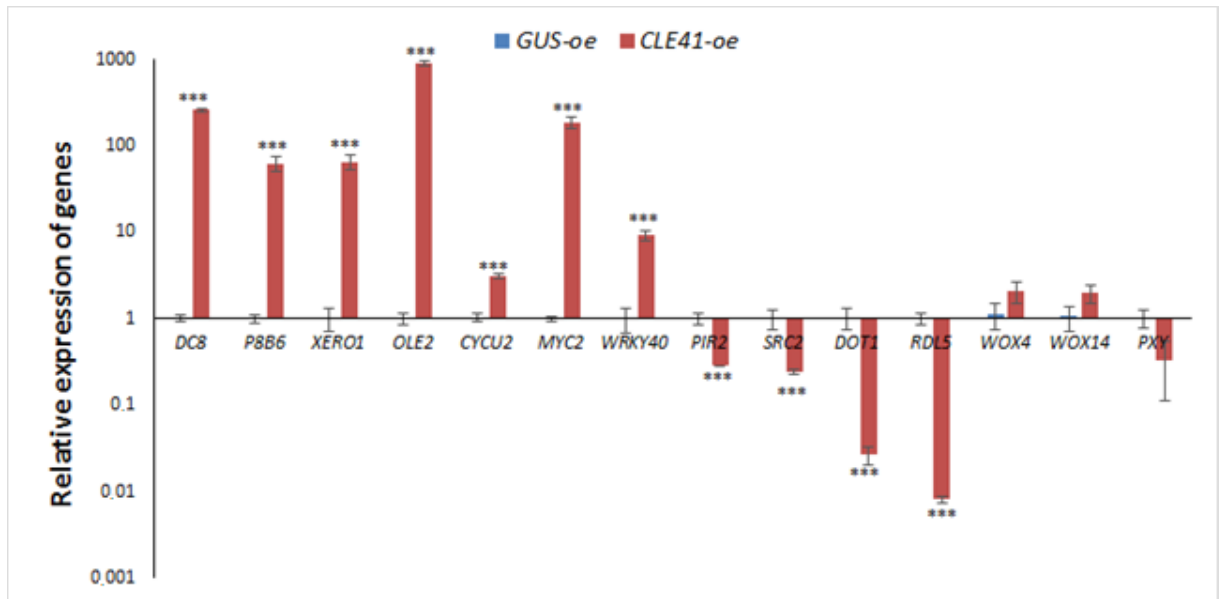
Figure 4. Gene expression analysis by qPCR: bars indicate corresponding genes which were upregulated or downregulated in the transcriptome experiment. Error bars indicate standard deviation of three technical repeats (*** p < 0.001).